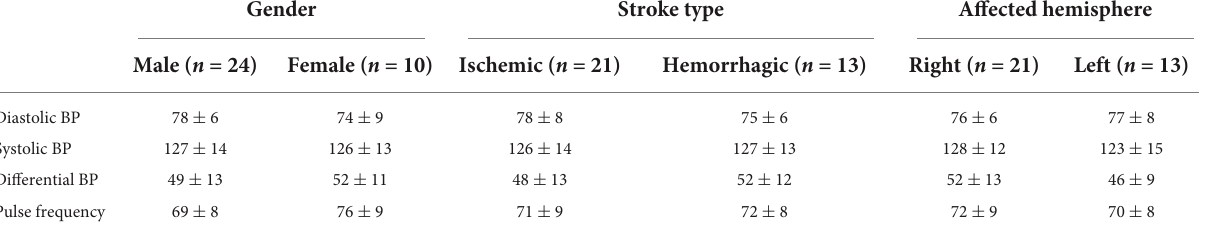
TABLE 3 Cardiovascular parameters at